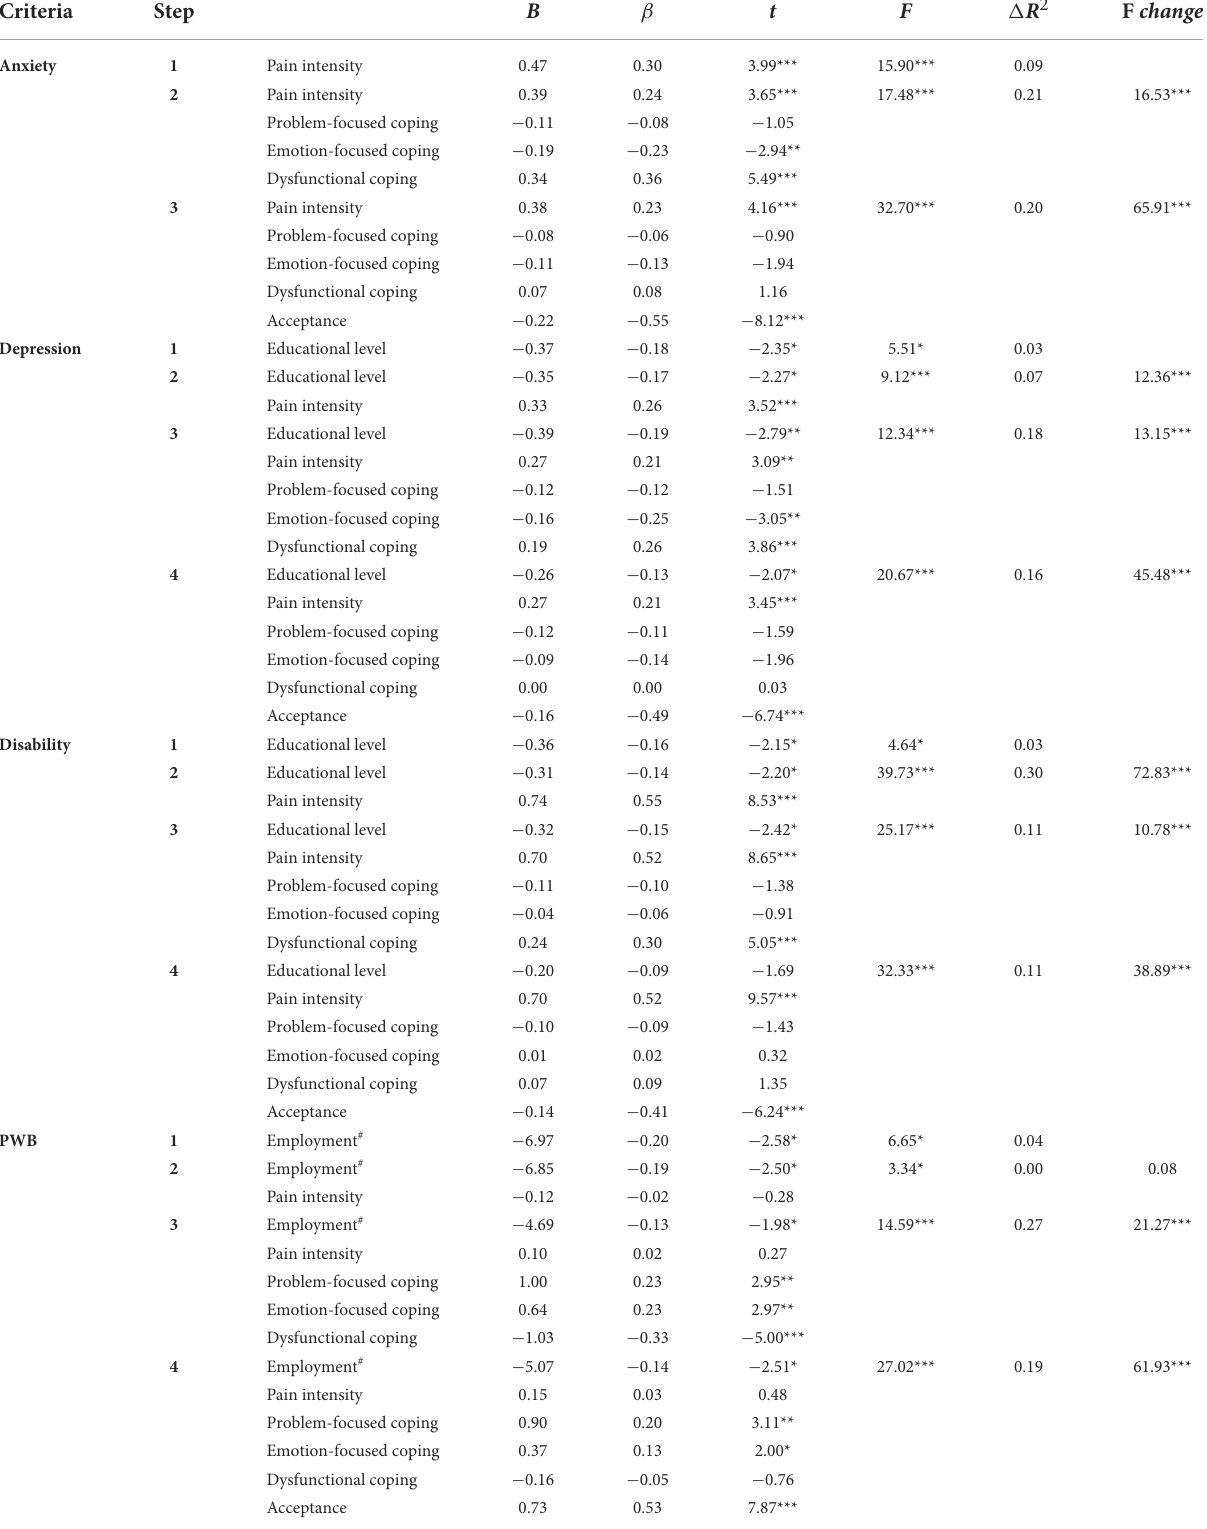
TABLE 2 HMR models to predict adjustment (when coping is entered before